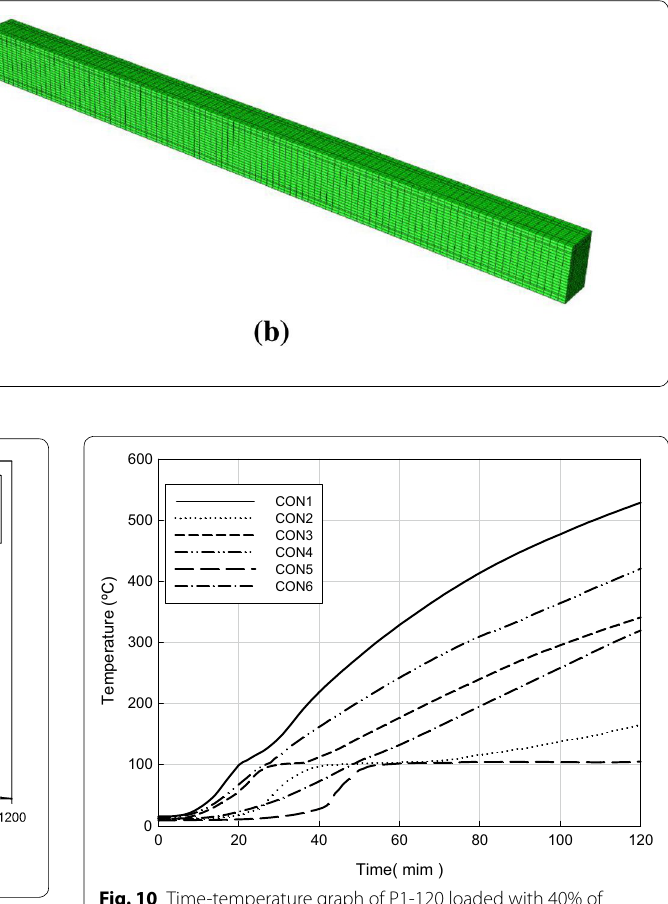
Fig. 10 Time-temperature graph of P1-120 loaded with 40% of nominal moment under